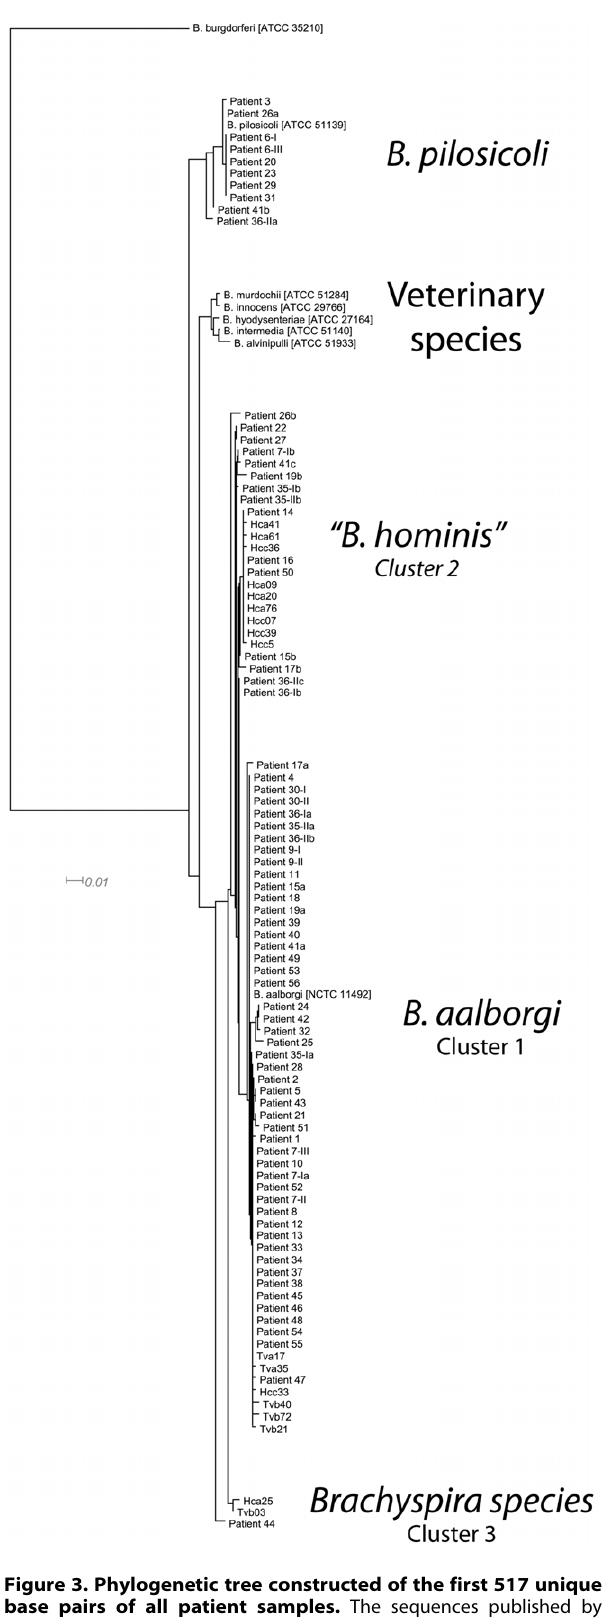
Figure 3. Phylogenetic tree constructed of the first 517 unique base pairs of all patient samples. The sequences published by Pettersson and colleagues (Hcc, Hca Tva and Tvb) and the sequences of the known type strains. The ‘‘B. hominis’’ group clearly differs phylogenetically from the known type strains and falls within